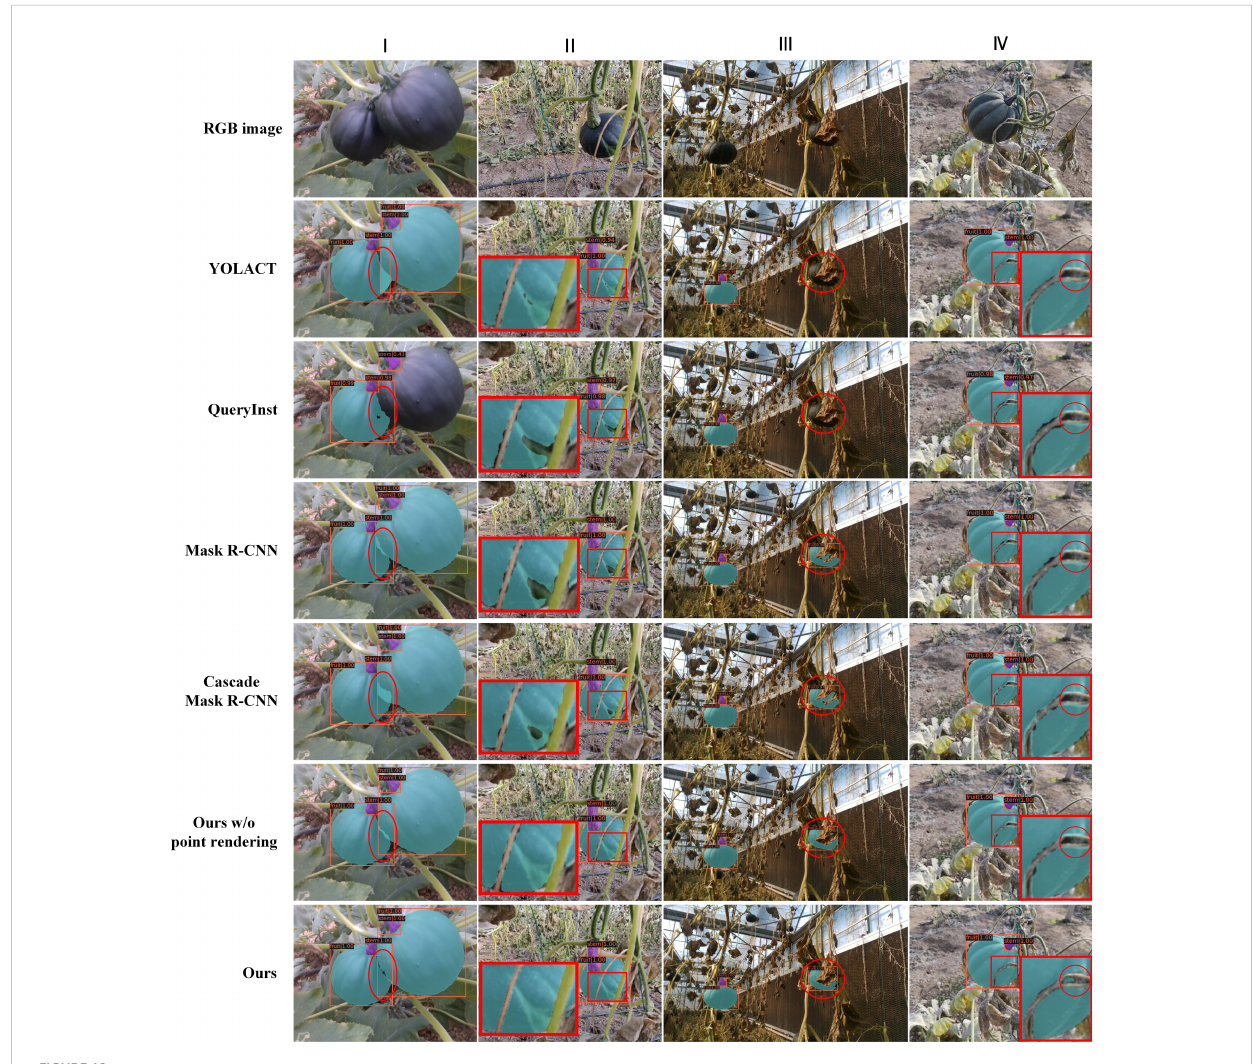
FIGURE 12 Example of pumpkin fruit and stem instance segmentation